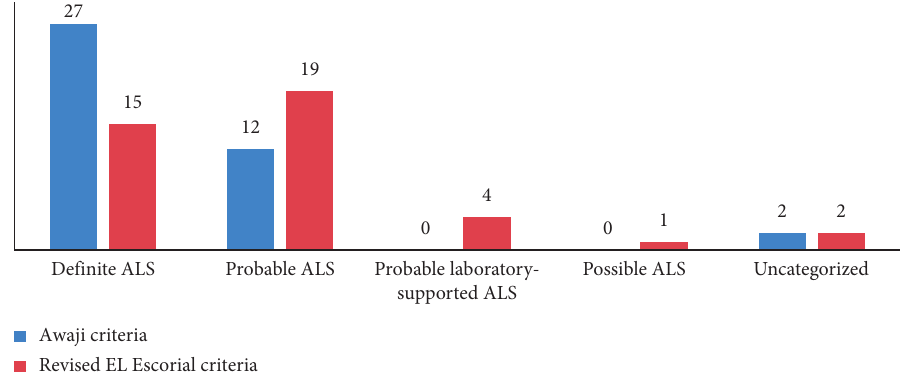
Figure 4: Diagnostic categories of ALS patients with a duration of evolution of the disease from 12 to 24 months, according to the AC and rEEC.